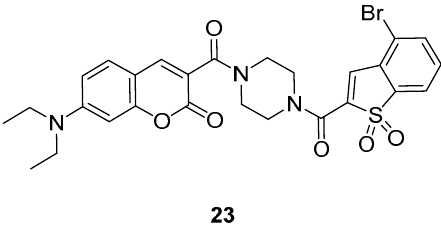
Figure 12. Chemical structure of compound 23.